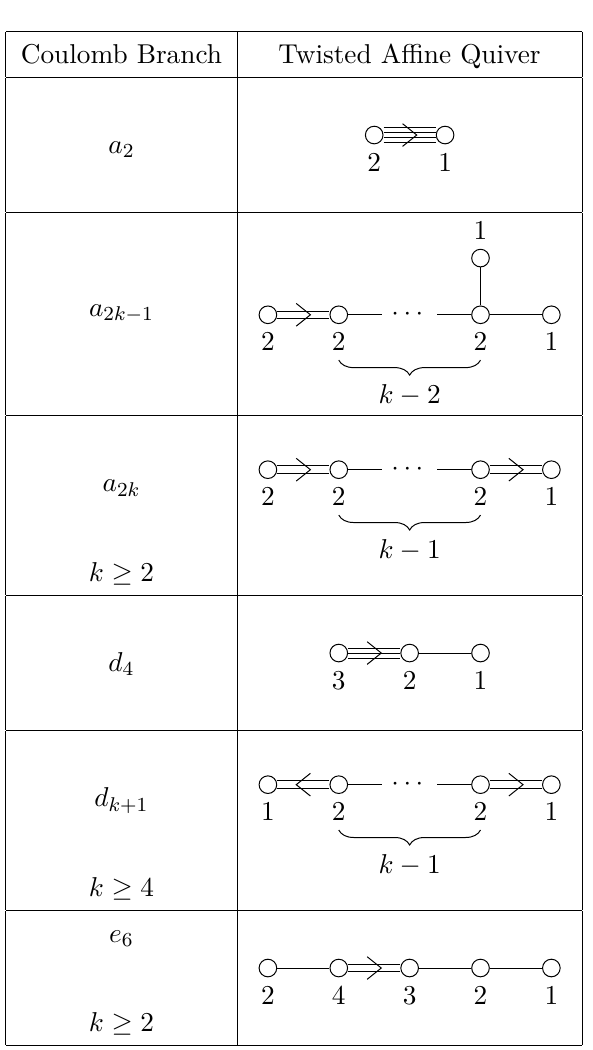
Table 2 . Quivers of the twisted affine Dynkin diagrams. The first column lists the Coulomb branch varieties, which are all the minimal nilpotent orbits g quivers in the second column when ungauged on a long node. These quivers will be referred to as “twisted affine g k